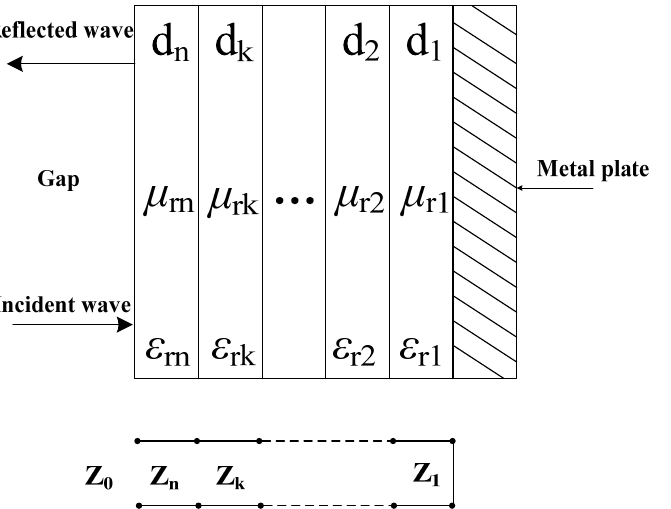
Figure 3. Schematic diagram of the absorbing structure composed of multilayer materials; equivalent transmission line model of the multilayer composite structure.